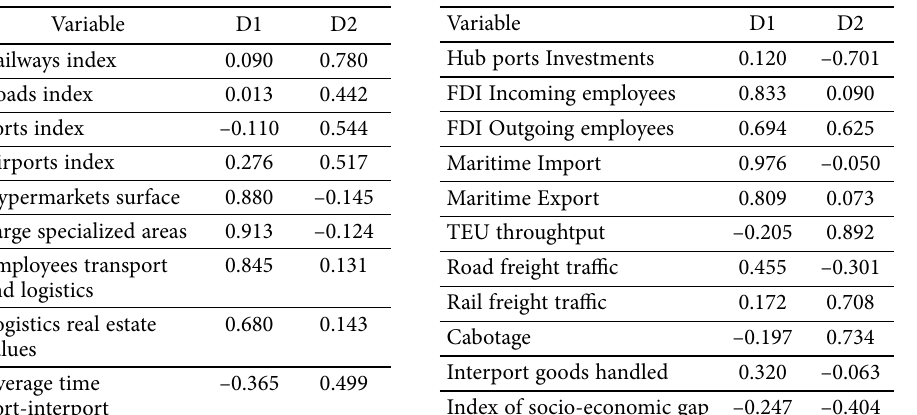
Table 4. Factor loadings NUTS3 level data Table 5. Factor loadings NUTS2 level